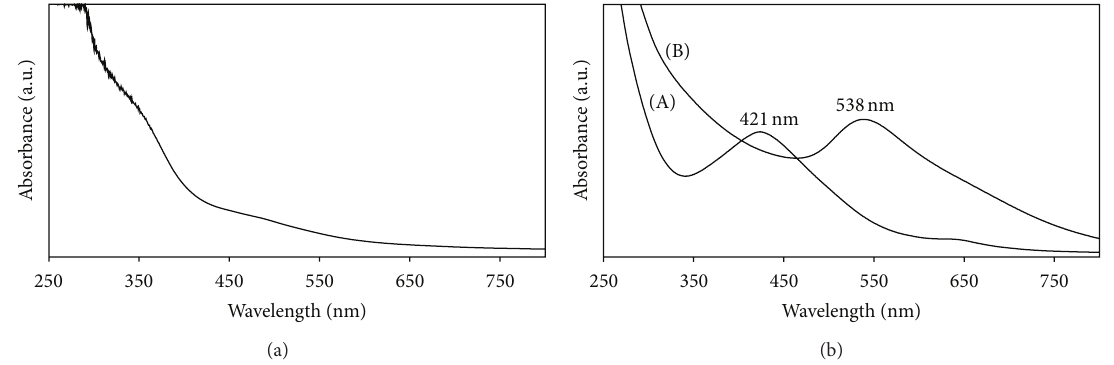
Figure 1: (a) UV-Vis spectrum of T. conoides extract; (b) synthesized colloidal Ag NPs (A) and Au NPs